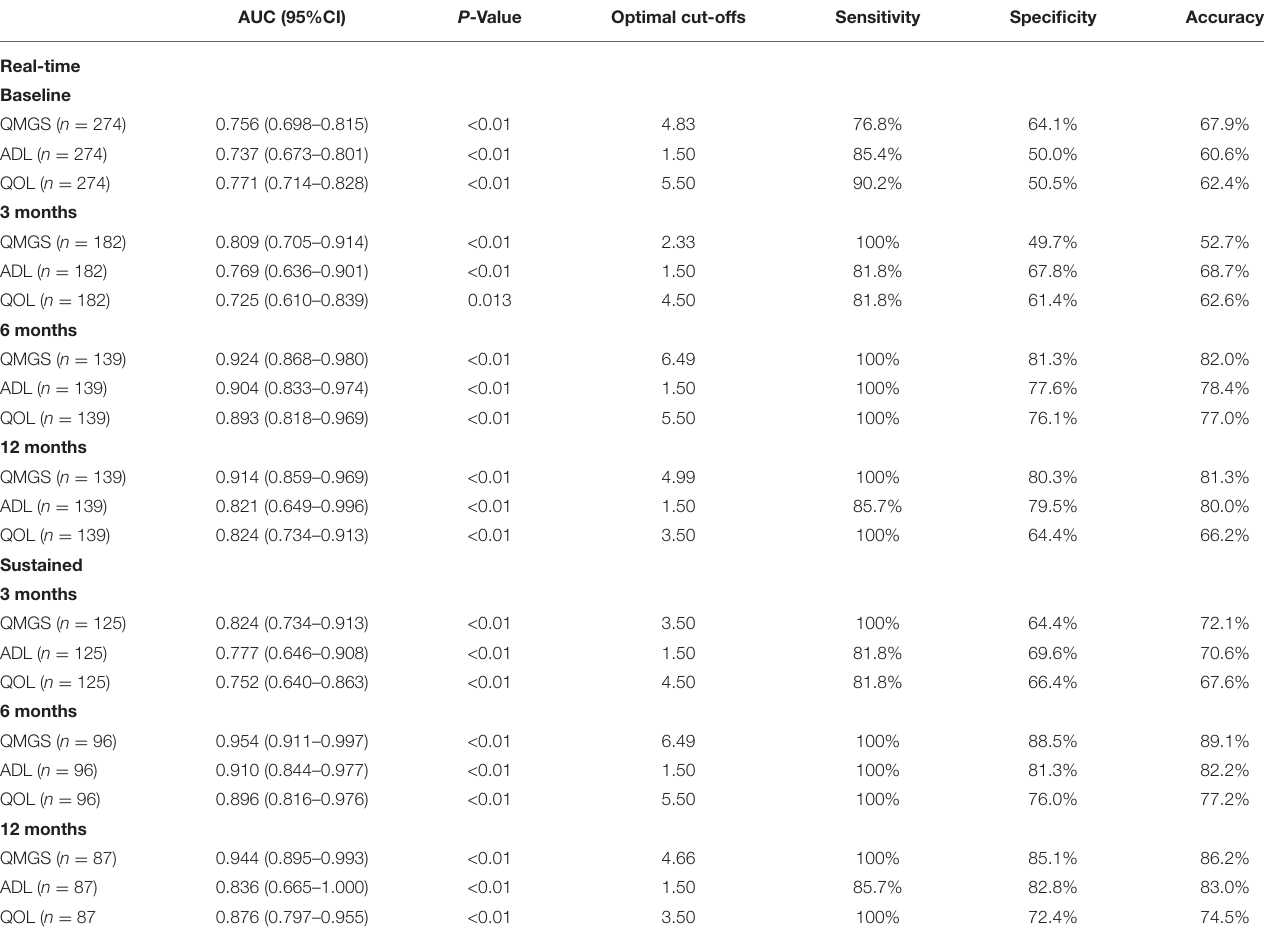
TABLE 8 | Cutoffs of QMGS, MG-ADL, and MG-QOL15 between “MM or better” and SI at each follow-up in the whole cohort. AUC (95%CI) P -Value Optimal cut-offs Sensitivity Specificity